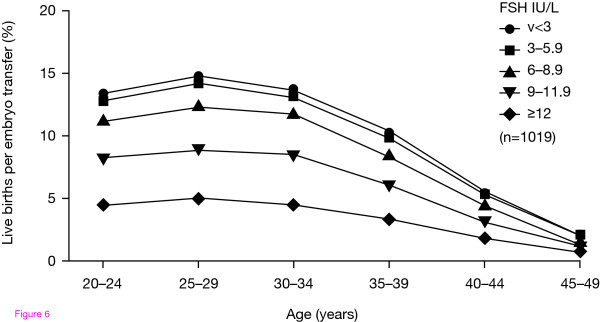
Reduction in the rate of live births per embryo transferred against both increasing chronological age and increasing basal FSH in a prior spontaneous menstrual cycle. Akande et al. Biological versus chronological ageing of oocytes, distinguishable by raised FSH levels in relation to the success of IVF treatment. Hum Reprod 2002;17:2003-2008. Reproduced by permission of Oxford University Press. FSH, follicle-stimulating hormone.